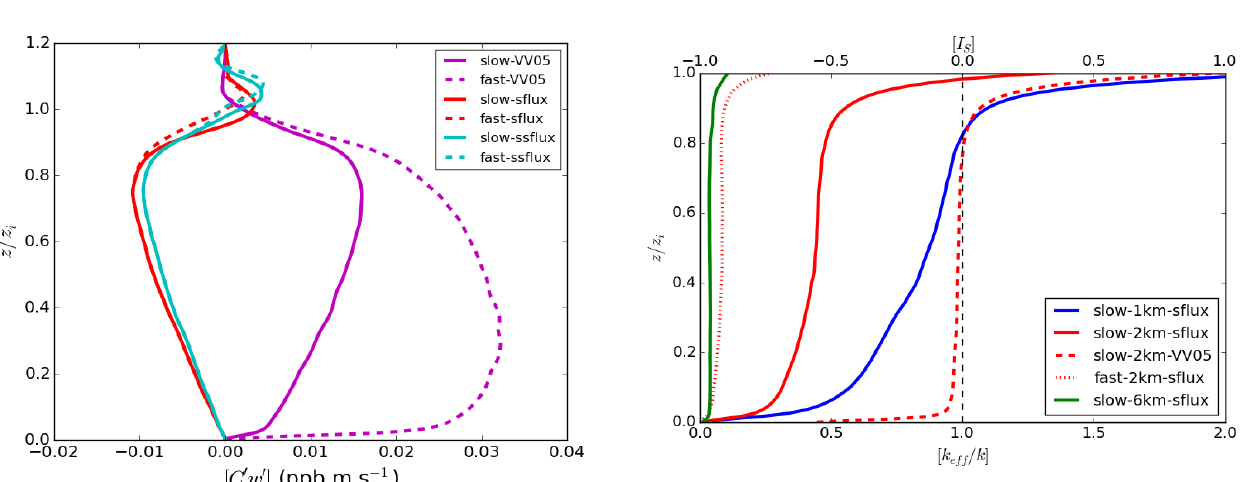
Figure 5. Vertical profiles of the horizontally averaged normalised effective chemical reaction rate [ k eff ] /k (and the horizontally aver- aged segregation coefficient [ I S ] (upper x axis)) with heterogeneous emissions for varied cases time averaged for the last 30min of the